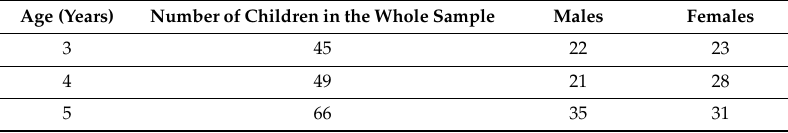
Table 1. Demographic data (age and gender) of the investigated